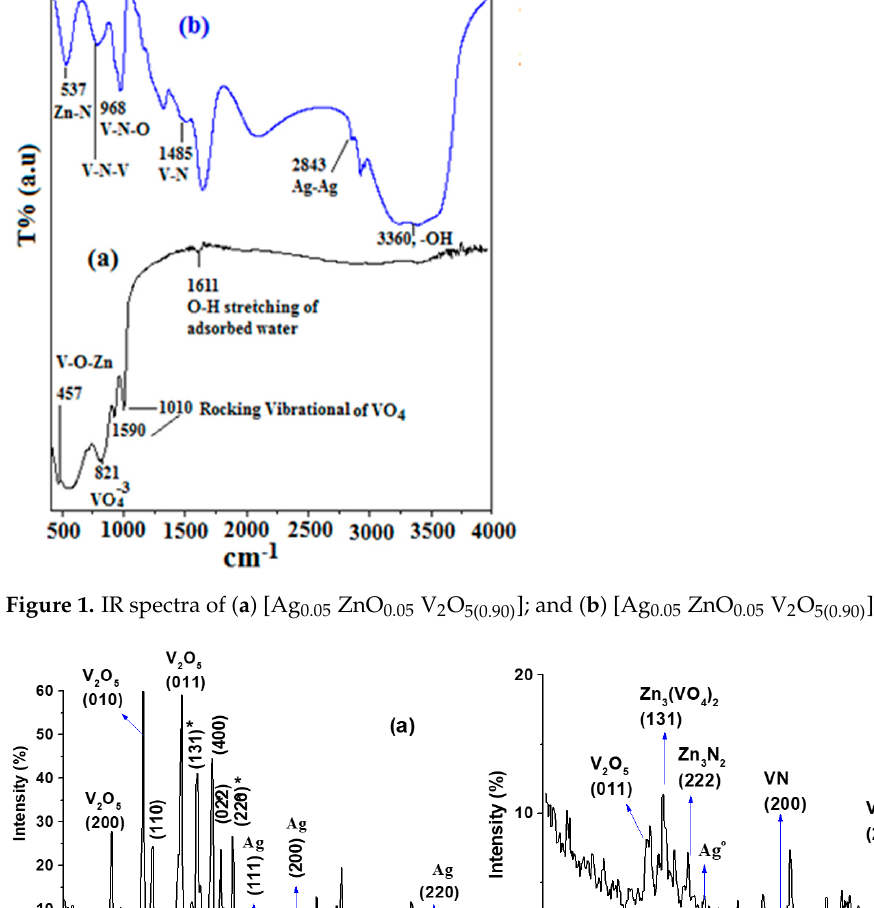
Figure 2. The XRD patterns of: ( a ) [Ag 0.05 ZnO 0.05 V 2 O 5(0.90) ]; and ( b ) [Ag 0.05 ZnO 0.05 V 2 O 5(0.90) ] N . The surface chemistry and the oxidation states of the metallic species were investigated by XP-spectra. Figure 3 depicts the survey spectrum and the deconvolution spectra of V, Zn, Ag, and O on the surface of [Ag 0.05 ZnO 0.05 V 2 O 5(0.90) ]. The deconvolution of the V2p spectrum indicates a multi-splitting accompanied by the characteristic satellites, suggesting the existence of different oxidation states [23]. The O1s signal is sufficiently close to the V2p1/2 to affect the background underneath of the V2p signal, as shown in Figure 3. The deconvolution of the Zn2p spectrum displays a doublet of intense and sharp peaks at 1021.88 eV and 1044.99 eV, assigned to Zn2p3/2 and Zn2p1/2 of Zn-nanorods [24]. A broad, low-intensity peak at 1021.07 eV was attributed to Zn-nanoparticles. The deconvolution of the Ag3d spectrum exhibits a doublet at 367.43 eV and 373.43 eV, characteristics for Ag3d5/2 and Ag3d3/2, respectively, with BE = 6.0 eV, referring to the metallic Ag [25,26]. For the O1s, a slight asymmetry of 530.11 eV is attributed to the O − 2 ion of the crystalline network. The broad, low-intensity peak at 531.6 eV was identified as O − and assigned to subsurface oxygen ions with lower electron densities than O − 2